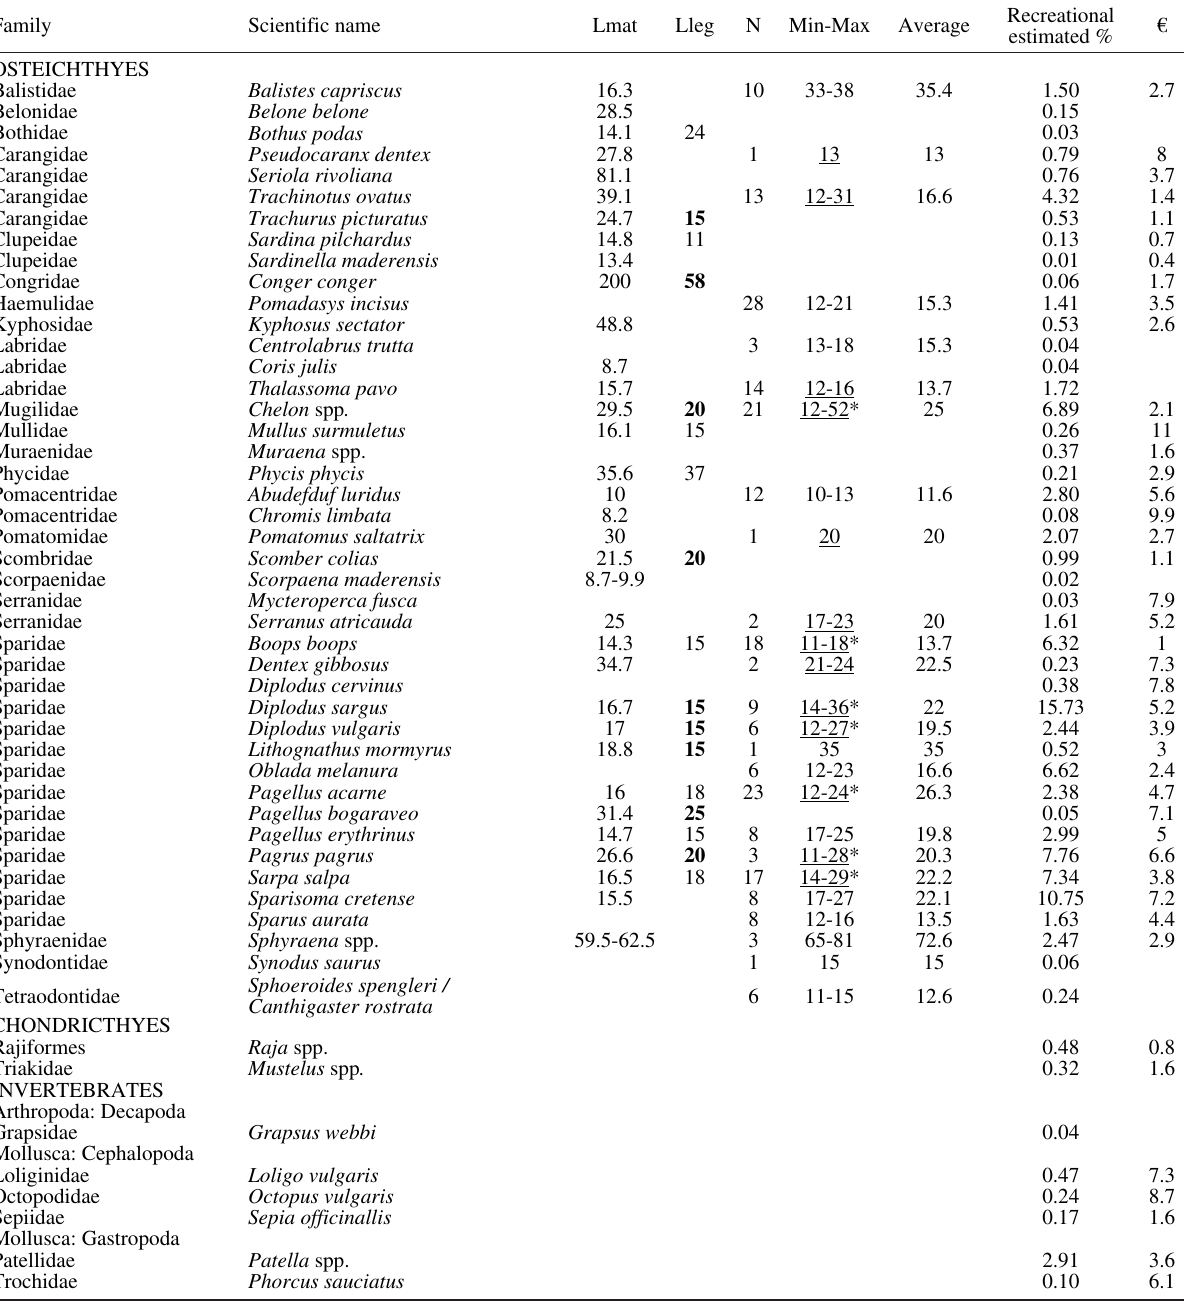
Table 3. – Species caught in Madeira waters. Lmat, length at maturity; Lleg, minimum landing size (numbers in bold are measures smaller than the minimum length at maturity); Min, minimum size; Max, maximum size (*, sizes smaller than those allowed by legislation; underlined, sizes smaller than the minimum length at maturity), all in cm; N, number of measured fishes; €, average first sale value (data provided by the Regional Directorate of Fisheries).